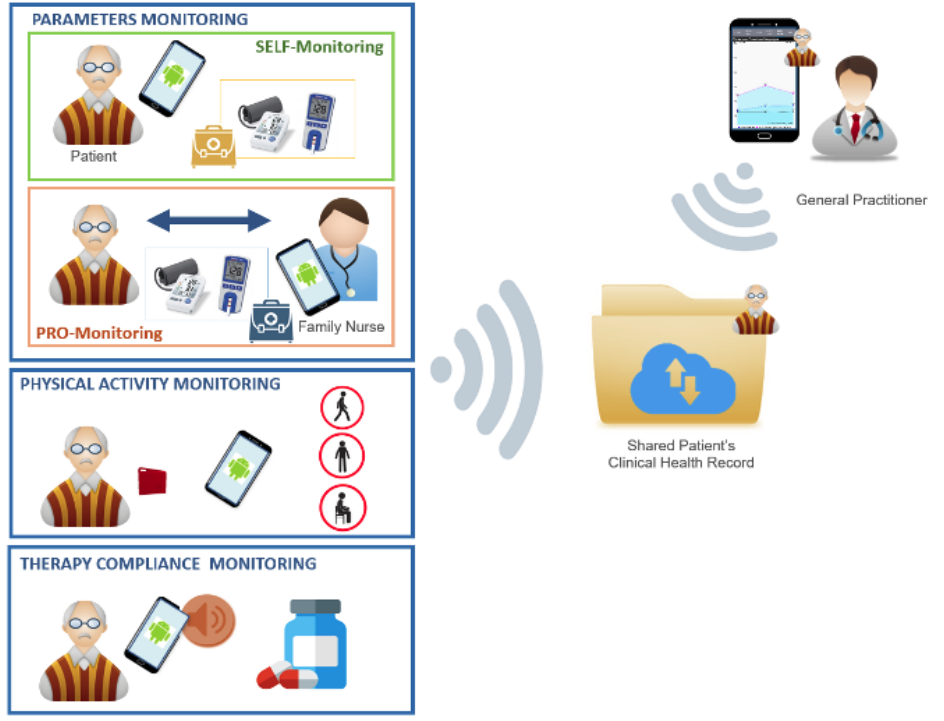
Figure 3. Overview of the System Monitoring Components and Data